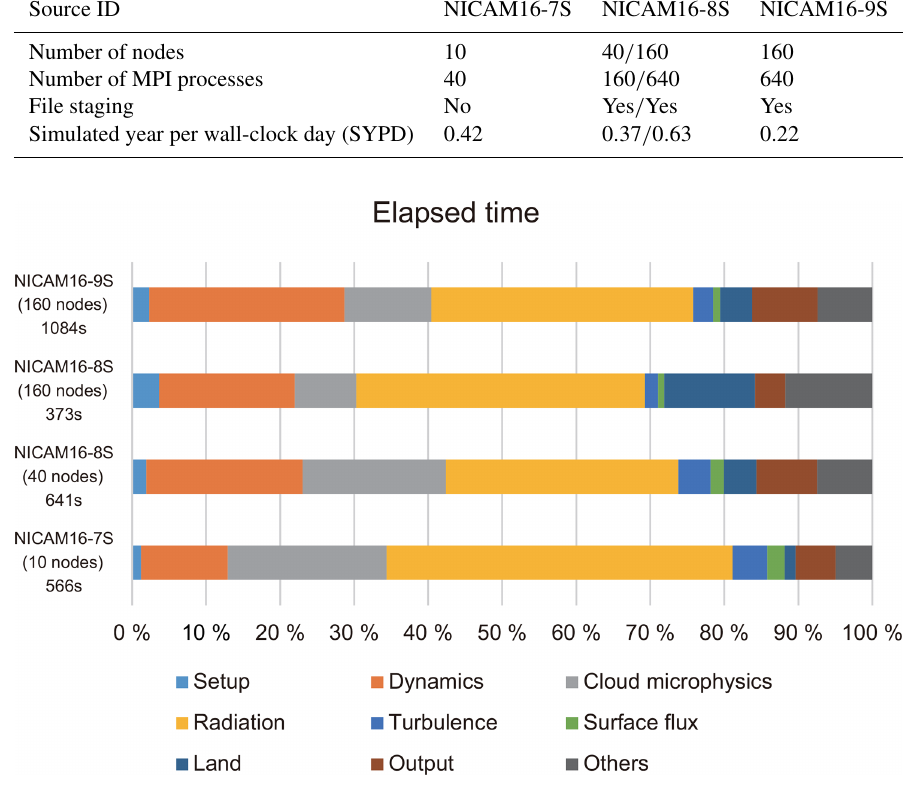
Figure 18. Percentage of elapsed time for each component of NICAM16-S on the Earth Simulator 3. Times were sampled from 6-month simulations (1 July 2004–31 December 2004). The computational time per 1d integration is shown on the